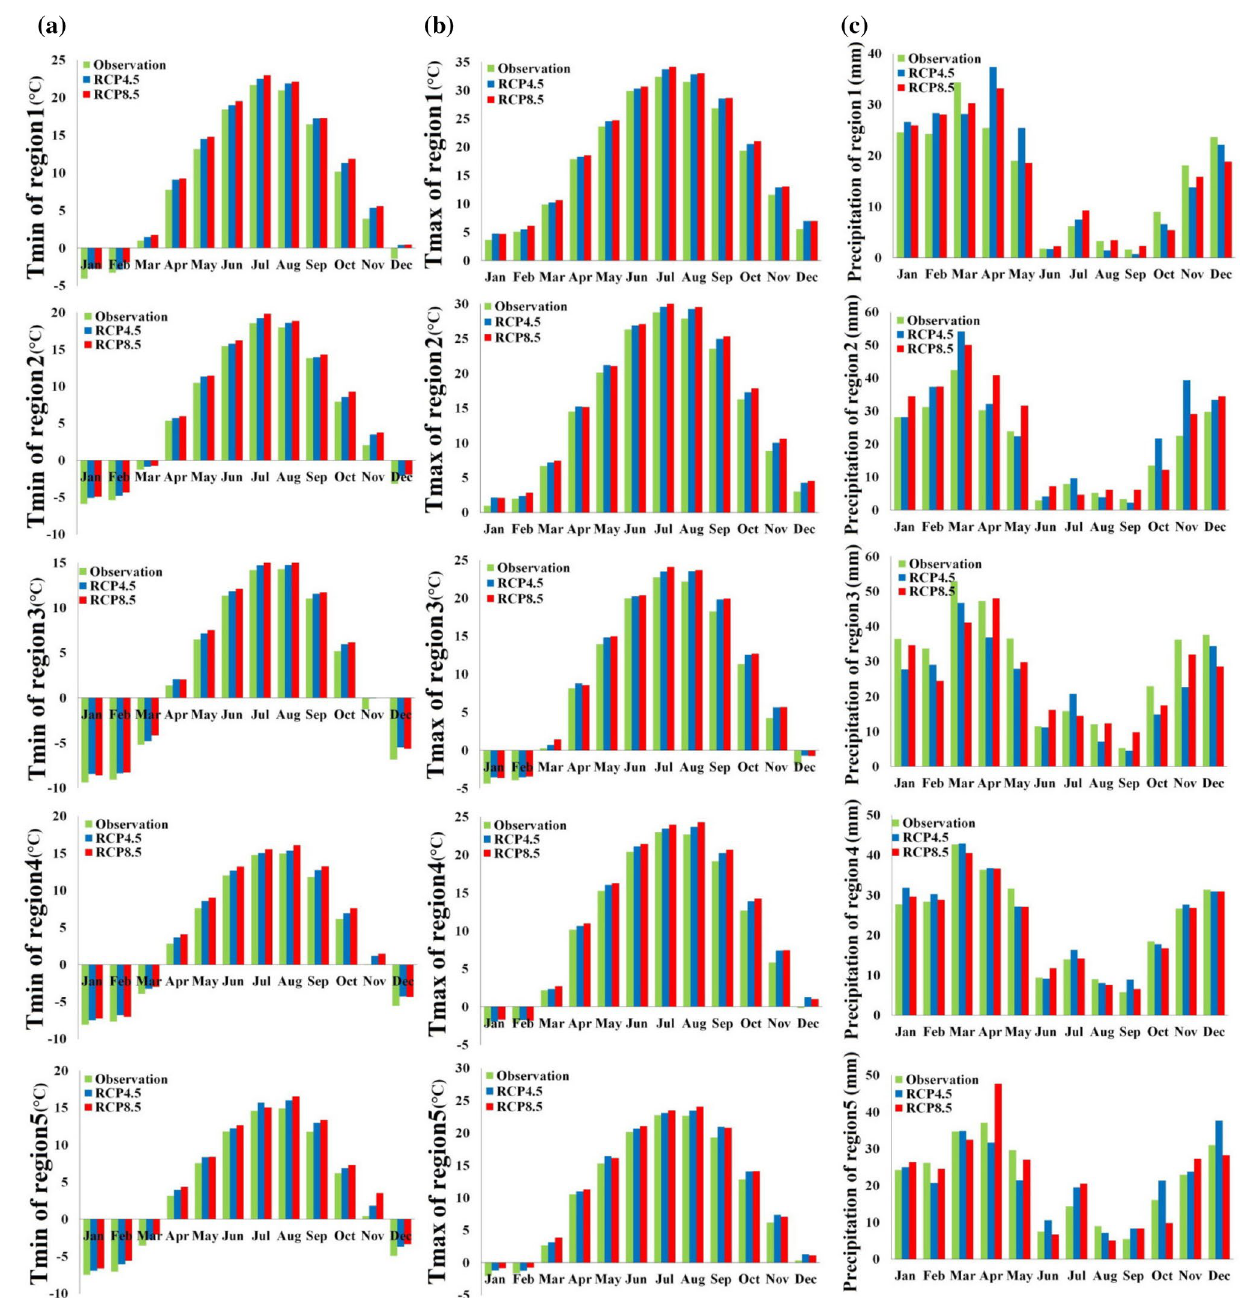
Fig. 18 Future projections (2025–2048) compared to the baseline period: a Tmin b Tmax c PCP under scenarios (RCP4.5 and